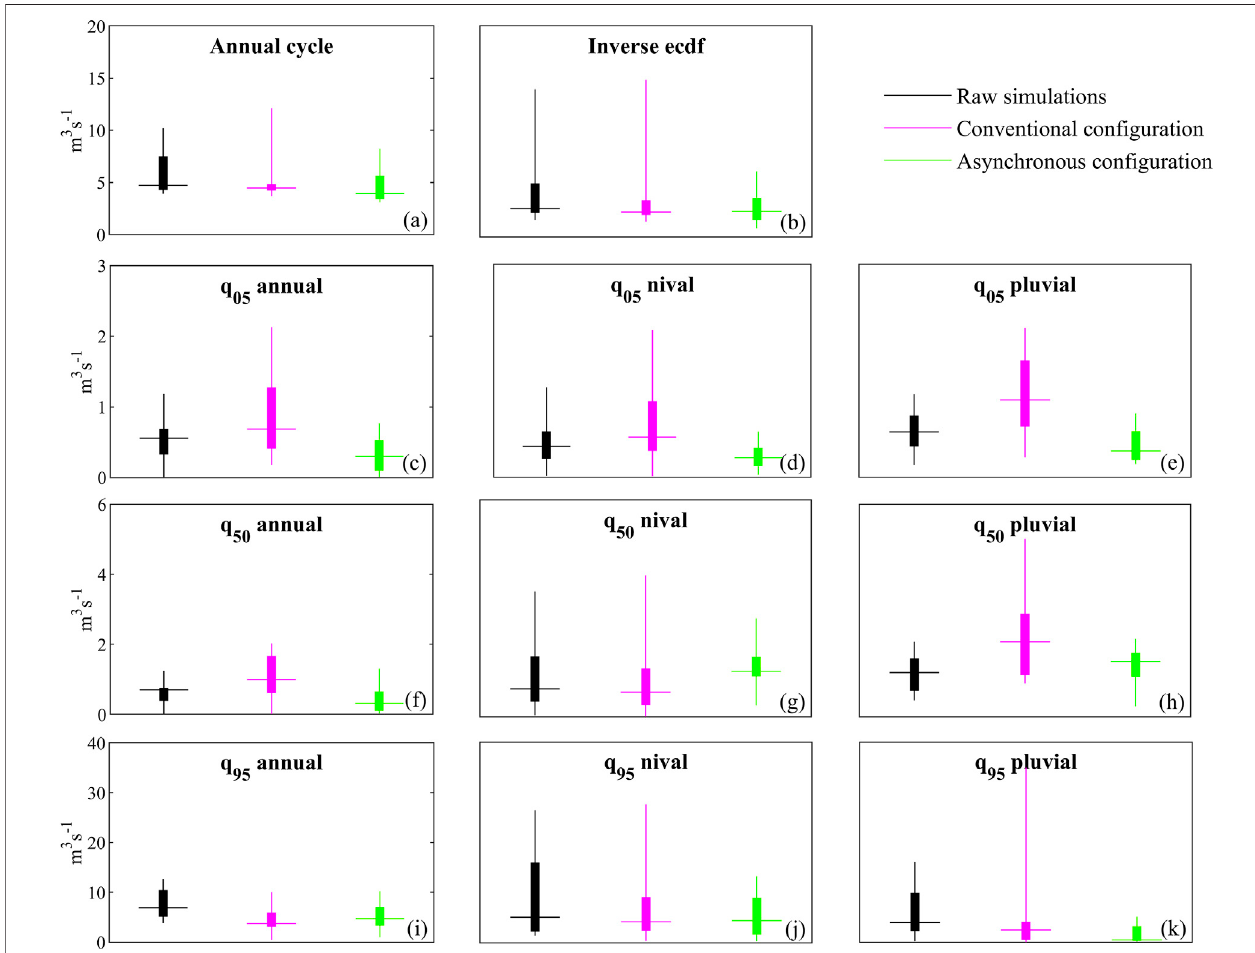
FIGURE 6 | Performance of stream fl ow simulations issued by raw climate simulations (black), conventional (magenta) and asynchronous (green) con fi gurations modelover DuLoup catchmentfrom1980to2009.Performanceisexpressedthroughtherootmeansquaredeviation(RMSD).Firstlinepresentsthedailymeanannual cycle and the inverse empirical cumulative distribution function (ecdf − 1 ). Following lines present seasonal quantiles values (q 05 , q 50 , and q 95 ). The nival season runs from December to May, the pluvial season, from June to November. Each distribution is composed by 16 realizations of the optimization process.